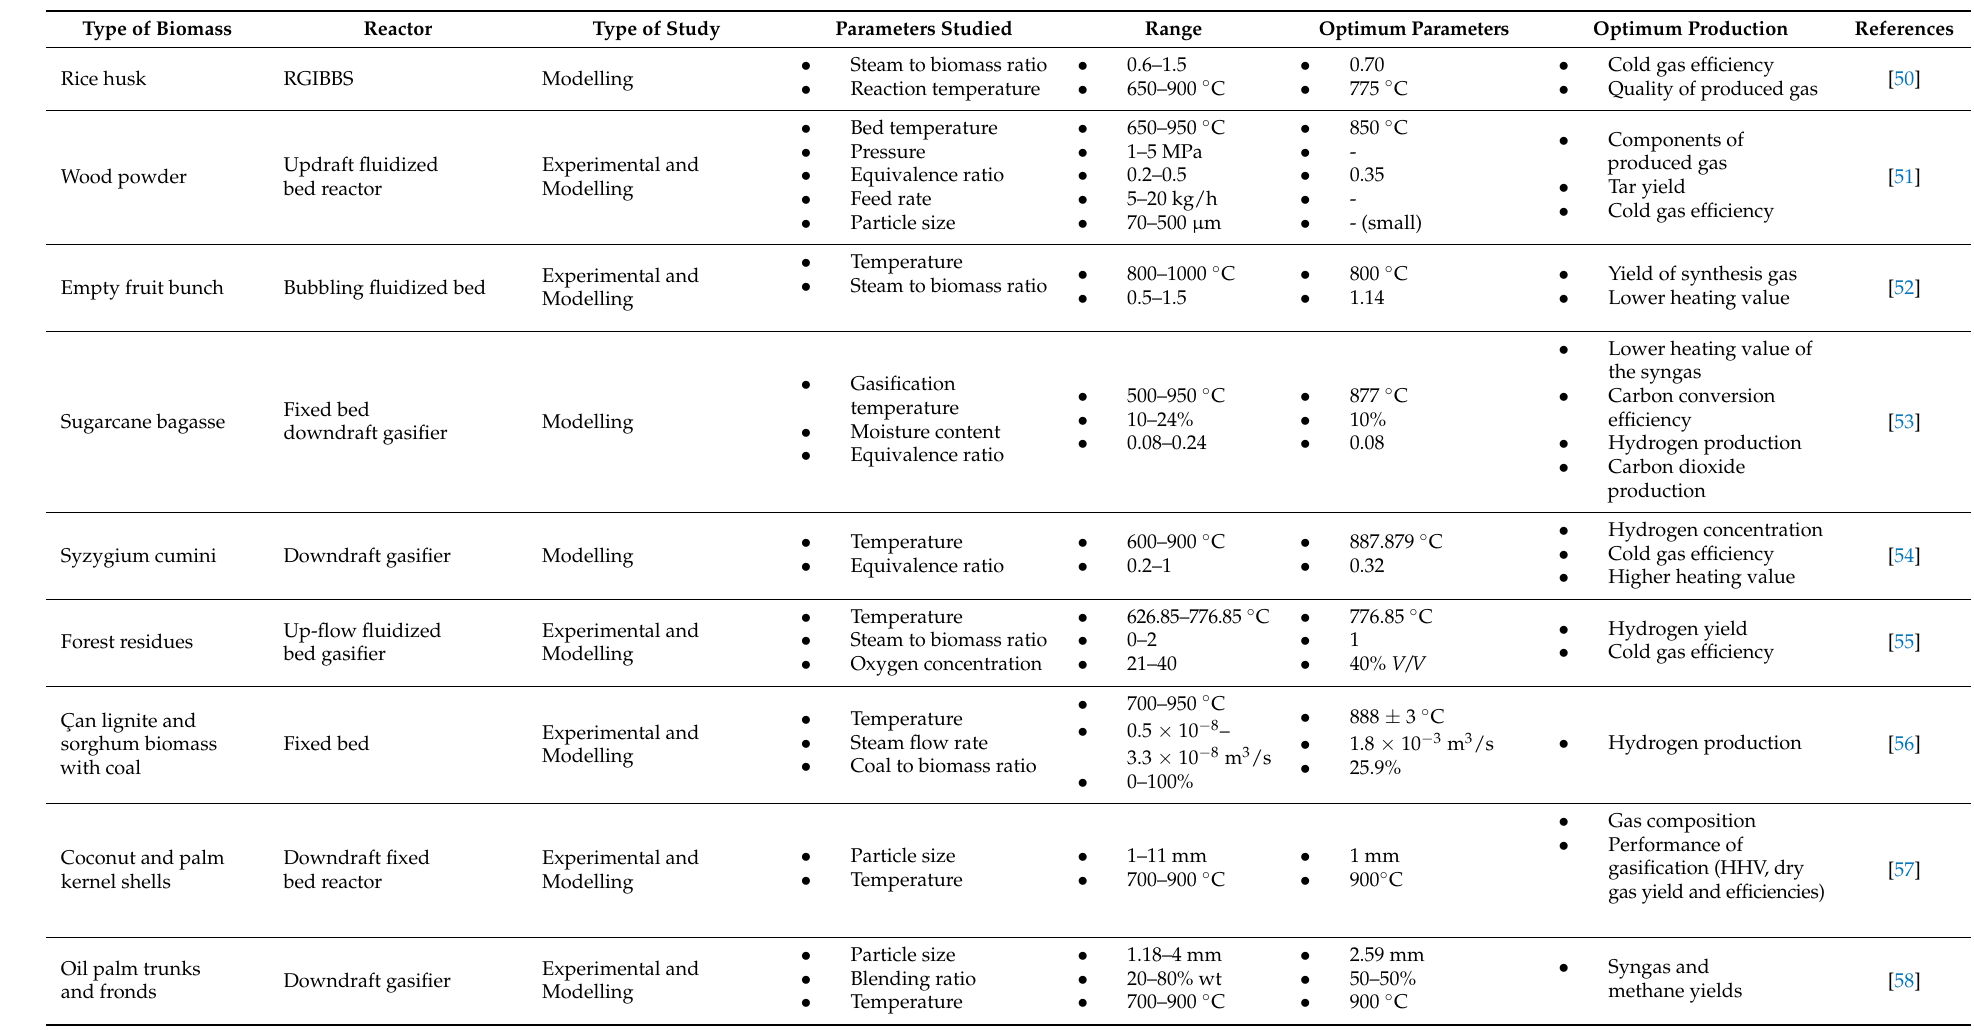
Table 2. Summary of studies on biomass gasification optimization using response surface